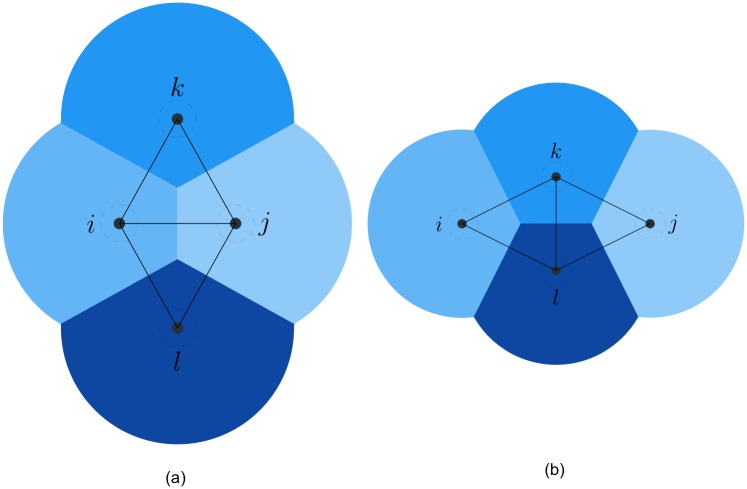
The third switching case.The case of flipping diagonals at the switching time. (a) before switching. (b) after switching.